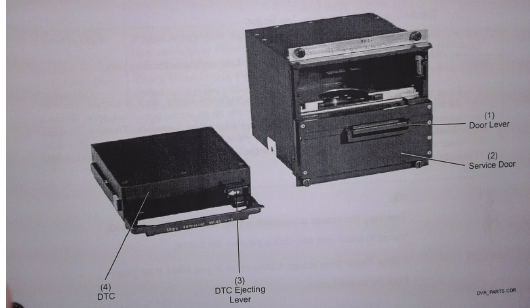
Figure 14 – DVR - Digital Video Recorder